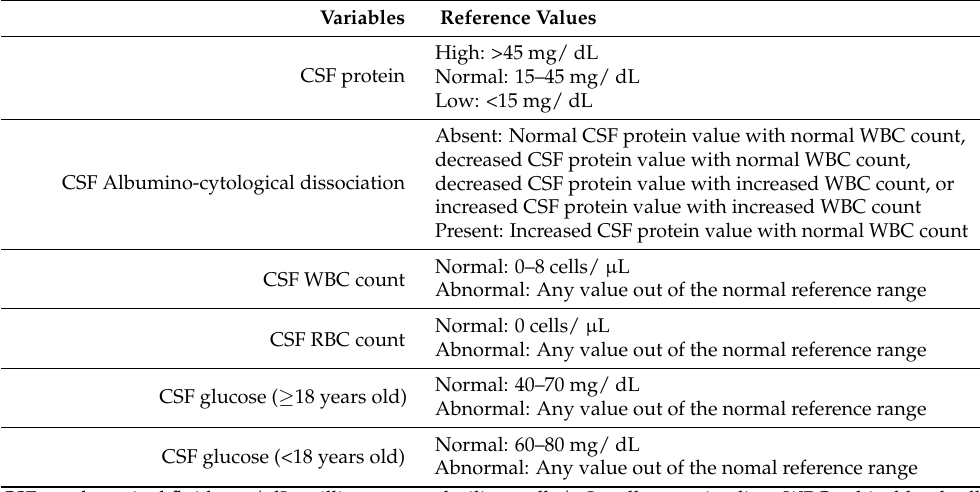
Table A1. Reference values for laboratory data.